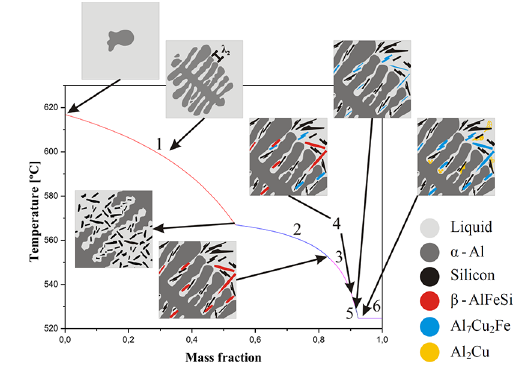
Figure 1. Solidification path of the investigated alloy: Reactions occurring during the solidification process.